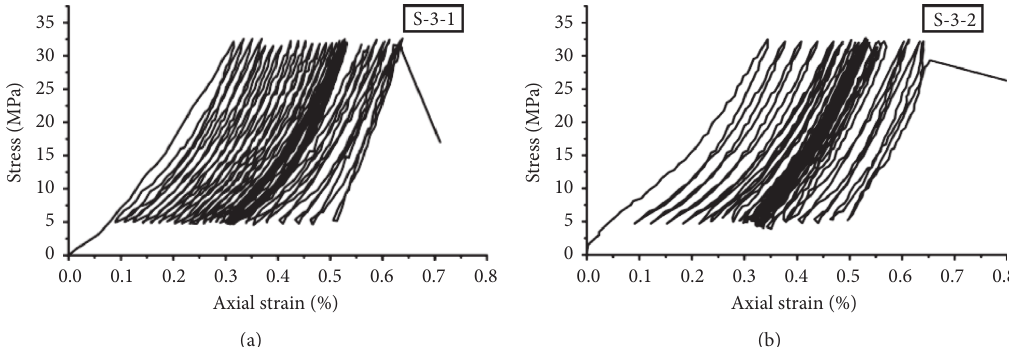
Figure 14: The stress-strain curves of S-3 rock sample group under cyclic loading and unloading (5–32MPa). (a) S-3-1 sample. (b) S-3-2